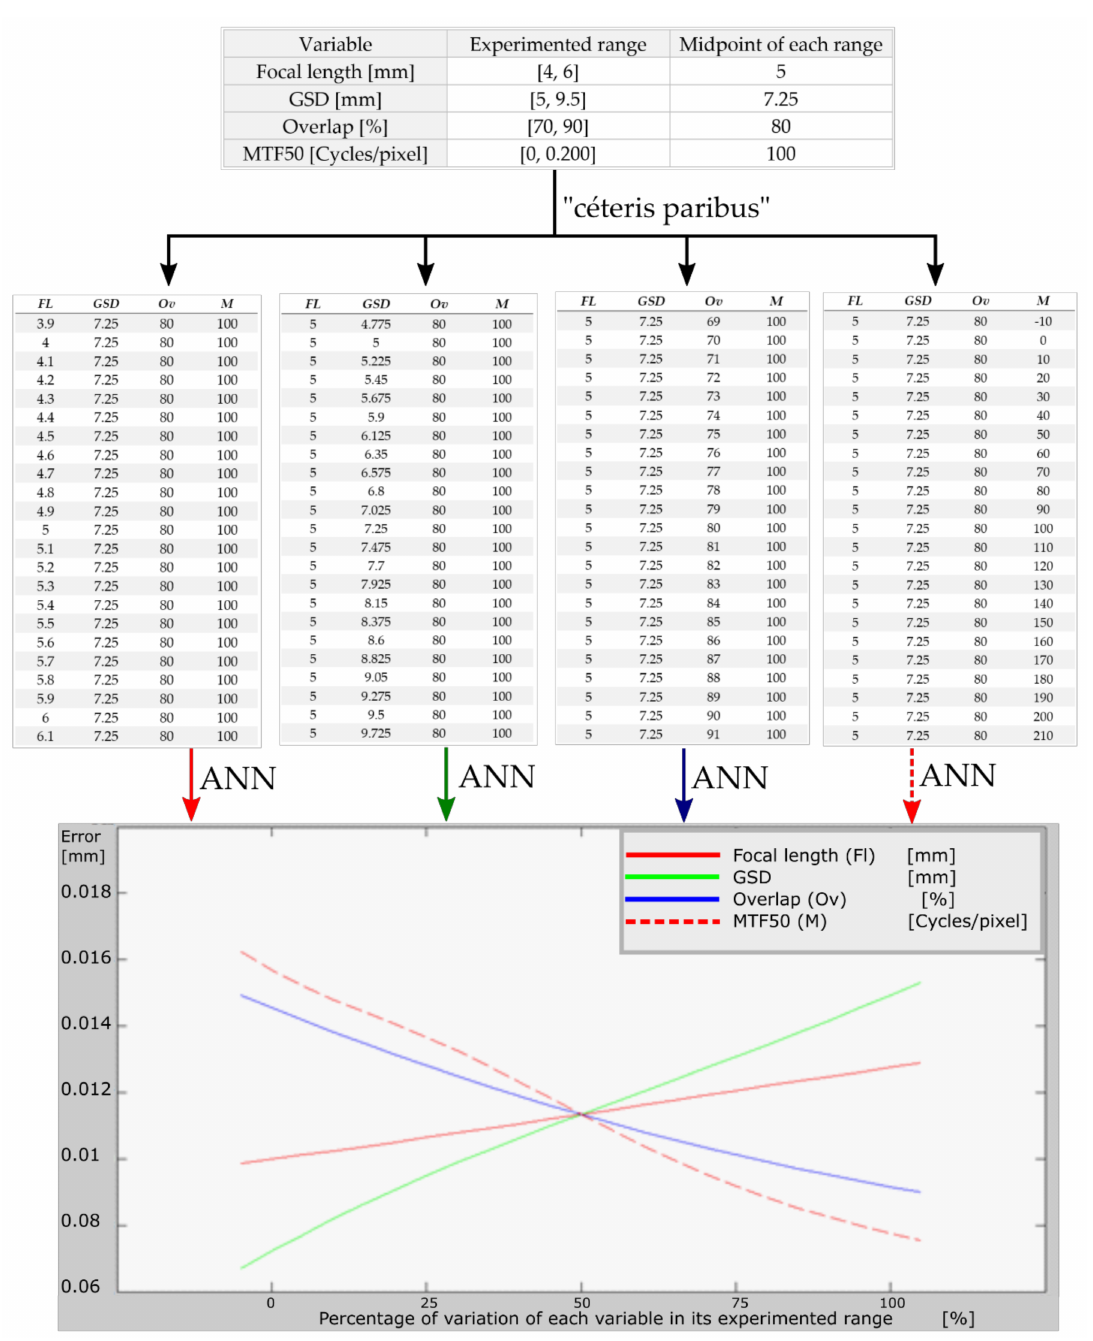
Figure 8. Influence of each variable on model